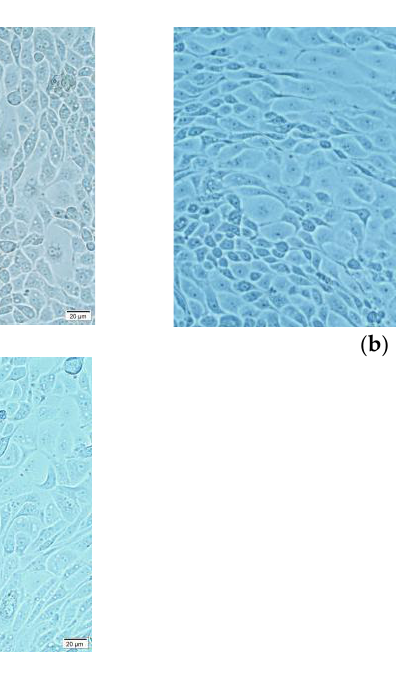
Figure A1 . Effect of Enterococcus faecalis infection on IPEC-J2 cell morphology. ( a ) Control group; ( b ) Enterococcus faecalis group, cells were elongated to a spindle shape; ( c ) TGF- β group.